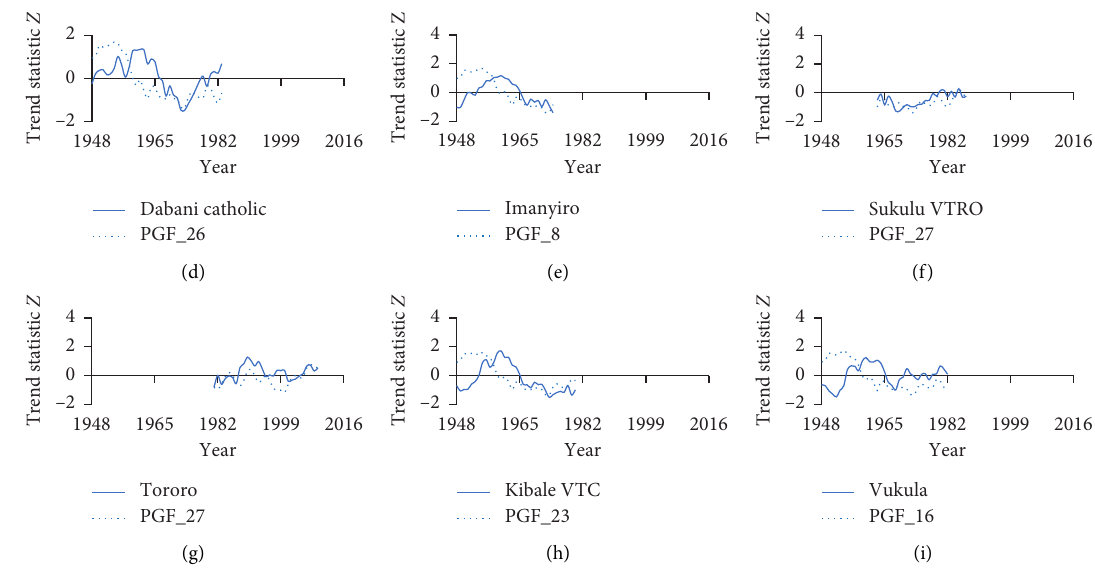
Figure 11: Variability of annual PGF and observed rainfall at stations (a) 1, (b) 2, (c) 3, (d) 4, (e) 5, (f) 6, (g) 7, (h) 8, and (i) 9. Table 3: Trend from observed and nearby PGF series at annual and seasonal